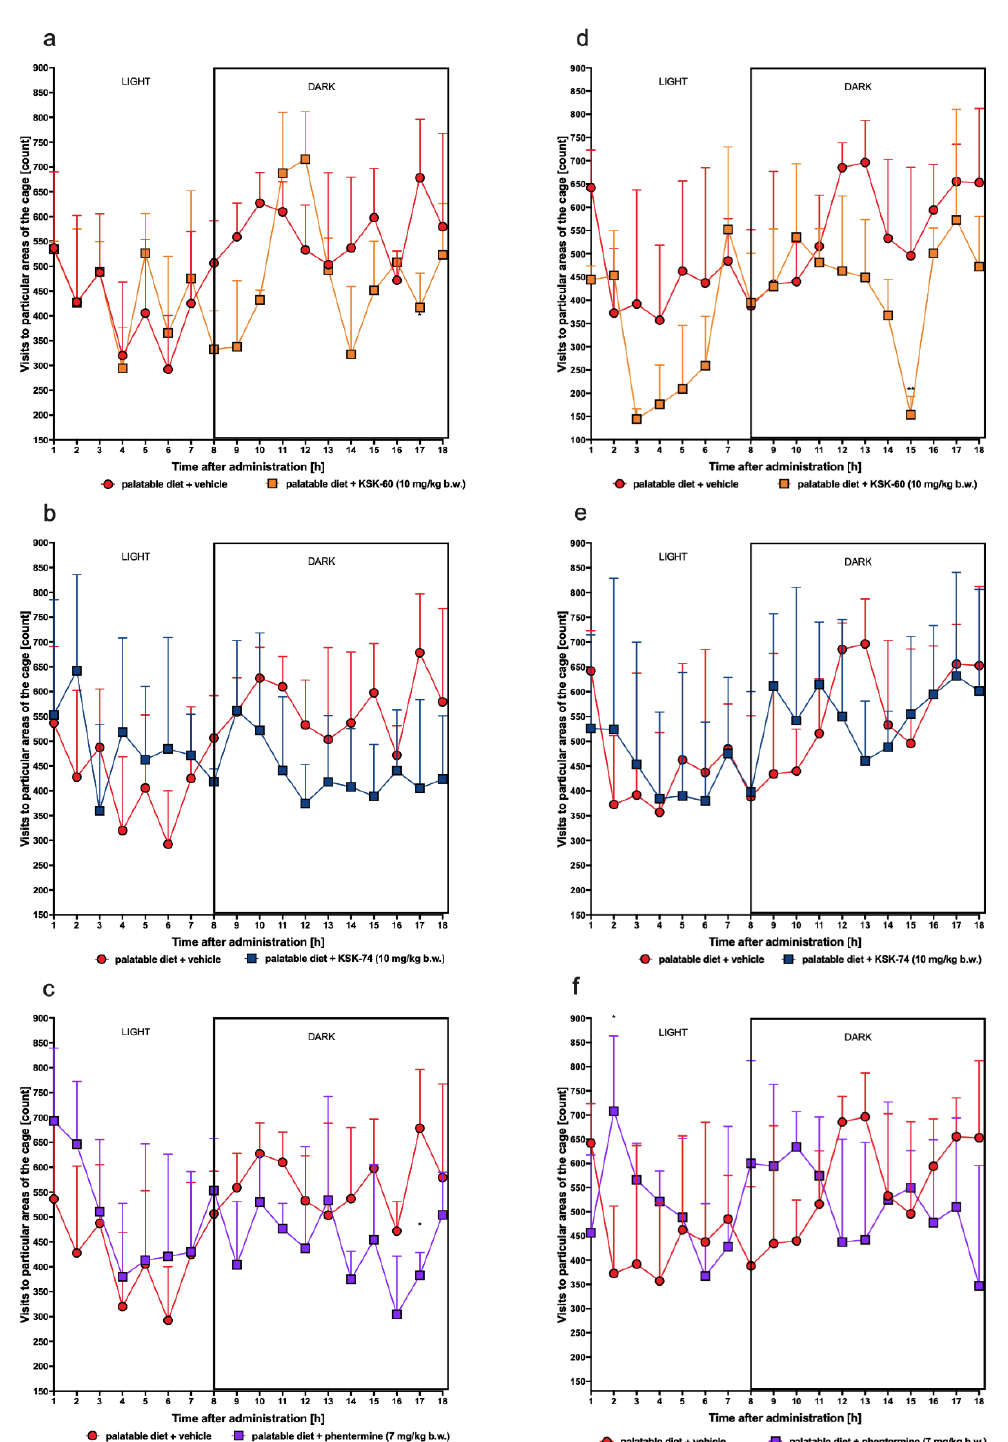
Figure 13. Spontaneous activity after the 1st and 27th administrations of the tested compounds. Results are expressed as means ± SD, n = 6. Comparisons were made using Multiple t -test; ( a ) palatable diet + vehicle vs. palatable diet + KSK-60 after the 1st administration; ( b ) palatable diet + vehicle vs. palatable diet + KSK-74 after the 1st administration; ( c ) palatable diet + vehicle vs. palatable diet + phentermine after the 1st administration; ( d ) palatable diet + vehicle vs. palatable diet + KSK-60 after the 27th administration; ( e ) palatable diet + vehicle vs. palatable diet + KSK-74 after the 27th administration; ( f ) palatable diet + vehicle vs. palatable diet + phentermine after the 27th administration; * p < 0.05, ** p < 0.01.